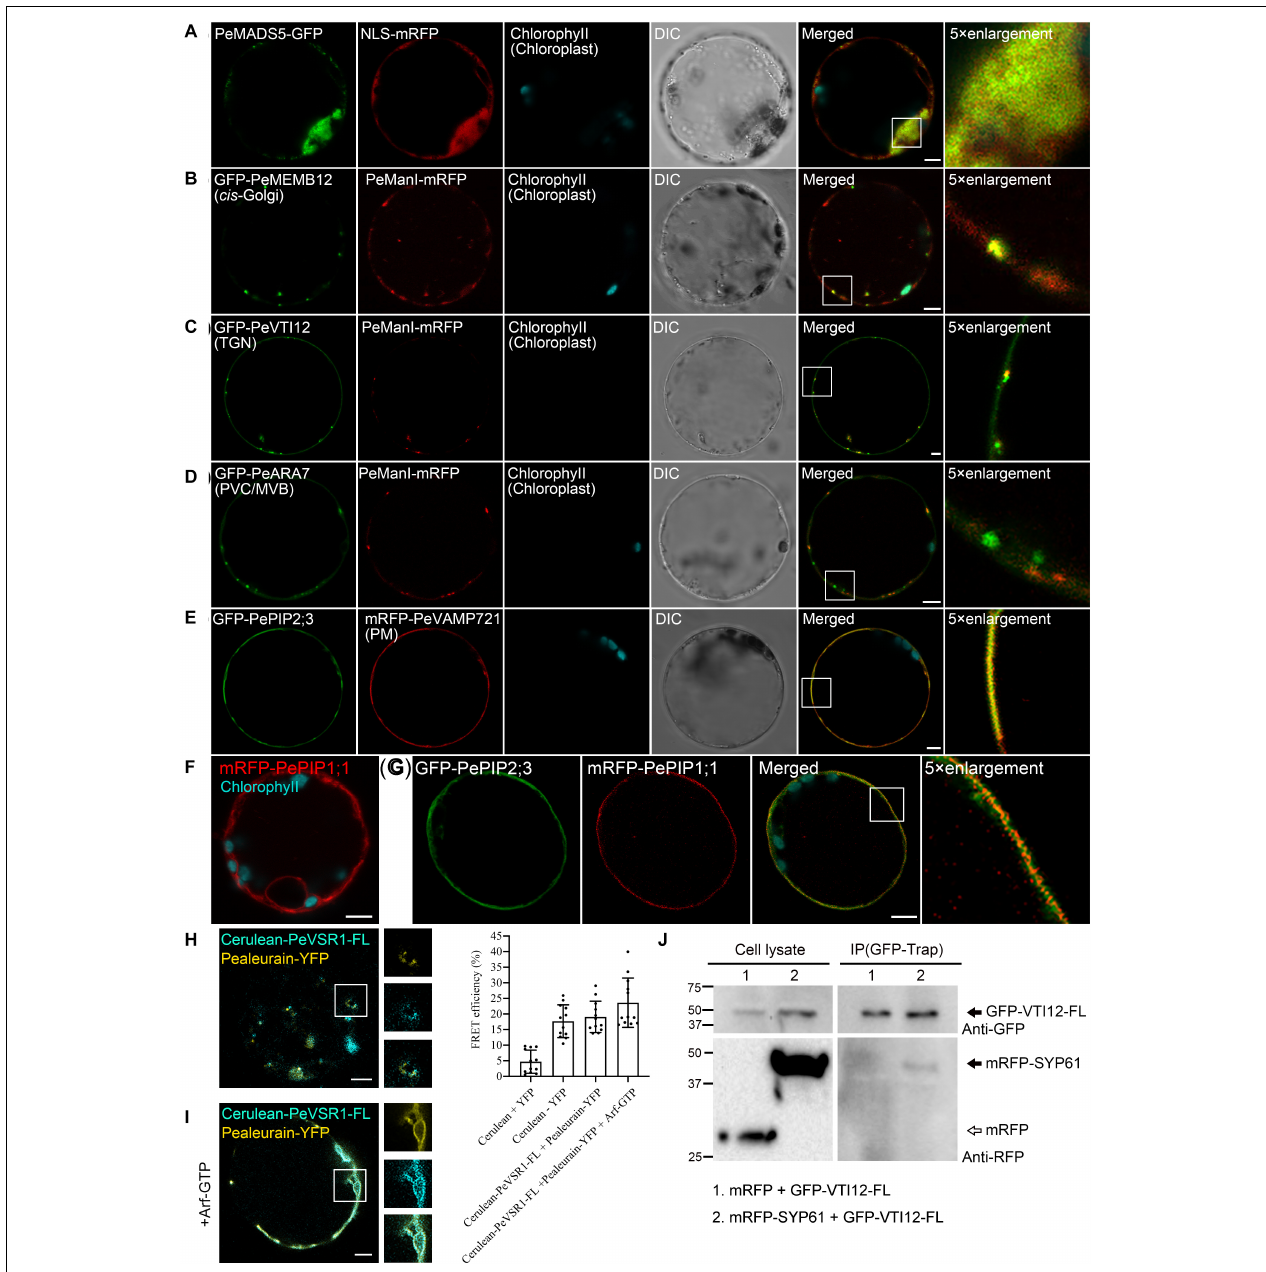
FIGURE 7 | Subcellular localization and protein–protein interaction analysis of uncharacterized proteins in moso bamboo protoplasts. (A) Colocalization of PeMADS5–GFP with the nucleus marker NLS–mRFP. (B–D) Subcellular localization of moso bamboo PeManI fused to mRFP in protoplasts. Coexpression of PeManI–mRFP with cis -Golgi marker GFP–PeMEMB12 (B) , TGN marker GFP–PeVTI12 (C) , and PVC/MVB marker GFP–PeARA7 (D) . Note that PeManI–mRFP colocalized with the cis -Golgi marker, associated with the trans -Golgi network (TGN) marker, but separated from the PVC/MVB marker. (E–G) Subcellular localization of PePIPs fused to GFP in moso bamboo protoplasts. Colocalization of GFP–PePIP2;3 with the PM marker mRFP–VAMP721 (E) . mRFP–PePIP1;1 fluorescence (F) . (G) Coexpression of GFP–PePIP2;3 and mRFP–PePIP1;1. Note the subcellular localization of mRFP–PePIP1;1 is relocalized from ER to plasma membrane by coexpression of GFP–PePIP2;3. (H,I) Acceptor photobleaching-fluorescence resonance energy transfer (FRET-AB) analysis between vacuolar sorting receptor (PeVSR1) and vacuolar cargo PeAleurain. Cerulean–PeVSR1–FL and PeAleurain–YFP were coexpressed in moso bamboo protoplasts followed by confocal imaging (left panel) and FRET-AB quantifications (right panel). The method to quantify FRET efficiency is described in the Materials and Methods section. For each group, at least 10 individual protoplasts were used for FRET efficiency quantification and statistical analysis. (J) Co-immunoprecipitation (co-IP) analysis between GFP-tagged full-length VTI12 (GFP–VTI12–FL) and mRFP-tagged SYP61 (mRFP–SYP61). Proteins were isolated from moso bamboo protoplasts coexpressing mRFP (lane 1) or mRFP–SYP61 (lane 2) with GFP–VTI12–FL as indicated, followed by immunoprecipitation (IP) using GFP–Trap agarose beads and subsequent immunoblot analysis on eluted proteins using anti-GFP or anti-RFP antibodies. mRFP was used as negative control. Arrow indicates VTI12. White and black arrowheads indicate mRFP and mRFP–SYP61, respectively. DIC, differential interference contrast. Scale bar = 5 µ m.